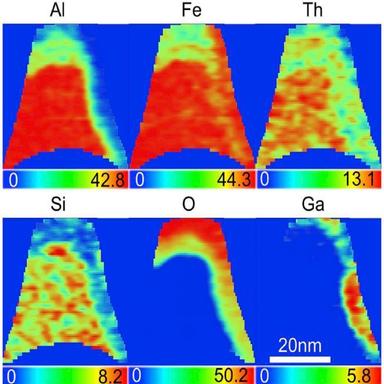
Elemental distribution contour maps (2D) of atoms in a 2 nm thick slice.